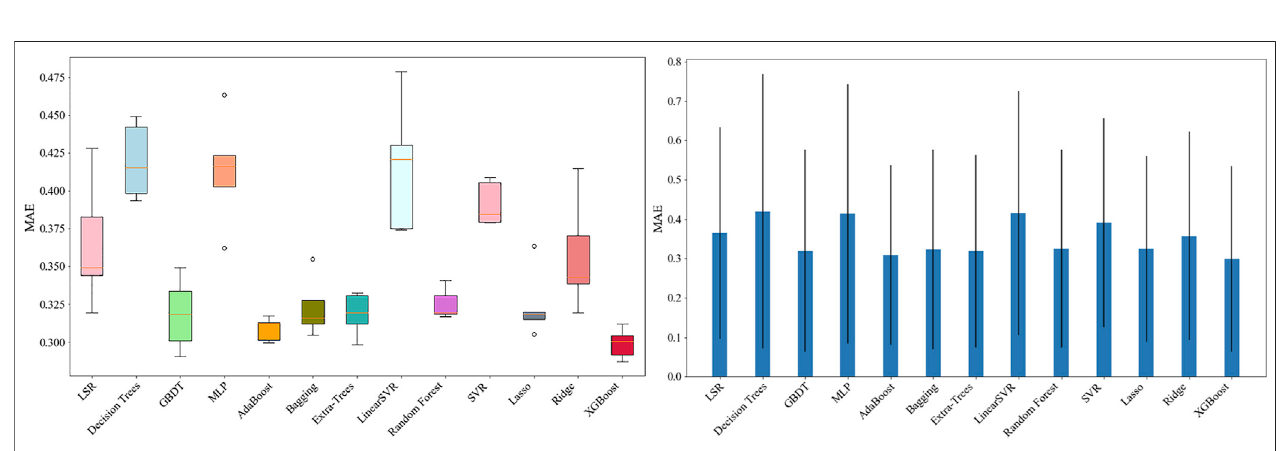
FIGURE 7 | Results of the initial model screening: the MAE of AdaBoost, ExtraTrees, and XGBoost had the lowest values within the smallest standard deviations, compared with that of the other models.